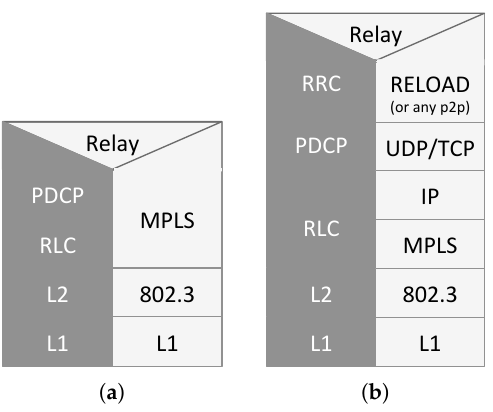
Figure 7. Enhanced eNodeB protocol stack. ( a ) User Plane; ( b ) Control Plane.